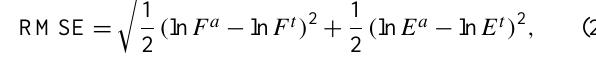
Fig. 10. Mean filtering and smoothing analysis root mean square errors of the two parameters of the online tracer model, as a func- tion of the DAW length for the IEnKS (finite-size variant), the EnKF/EnKS, and 4D-Var (with optimal inflation of the